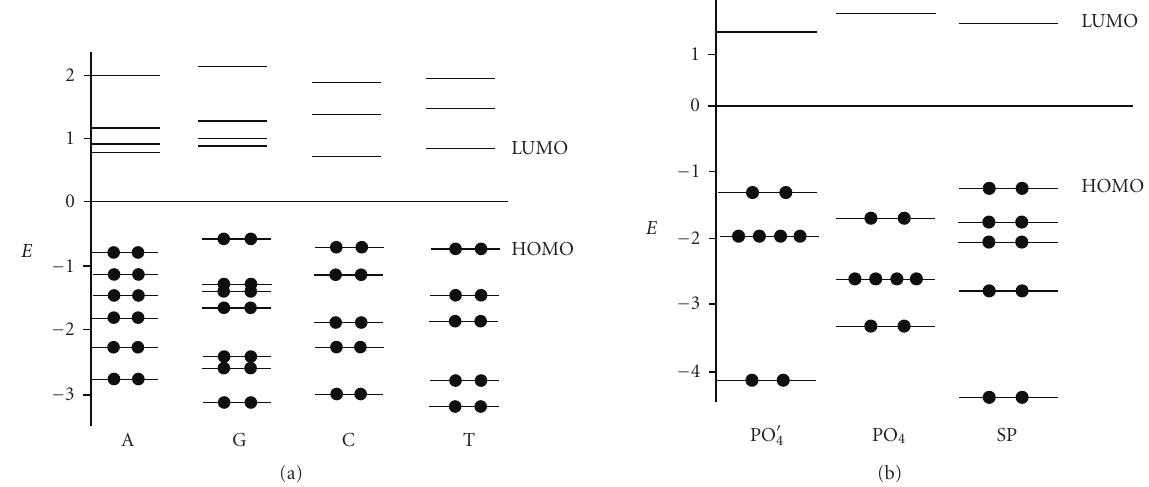
stands for the phosphate group 4